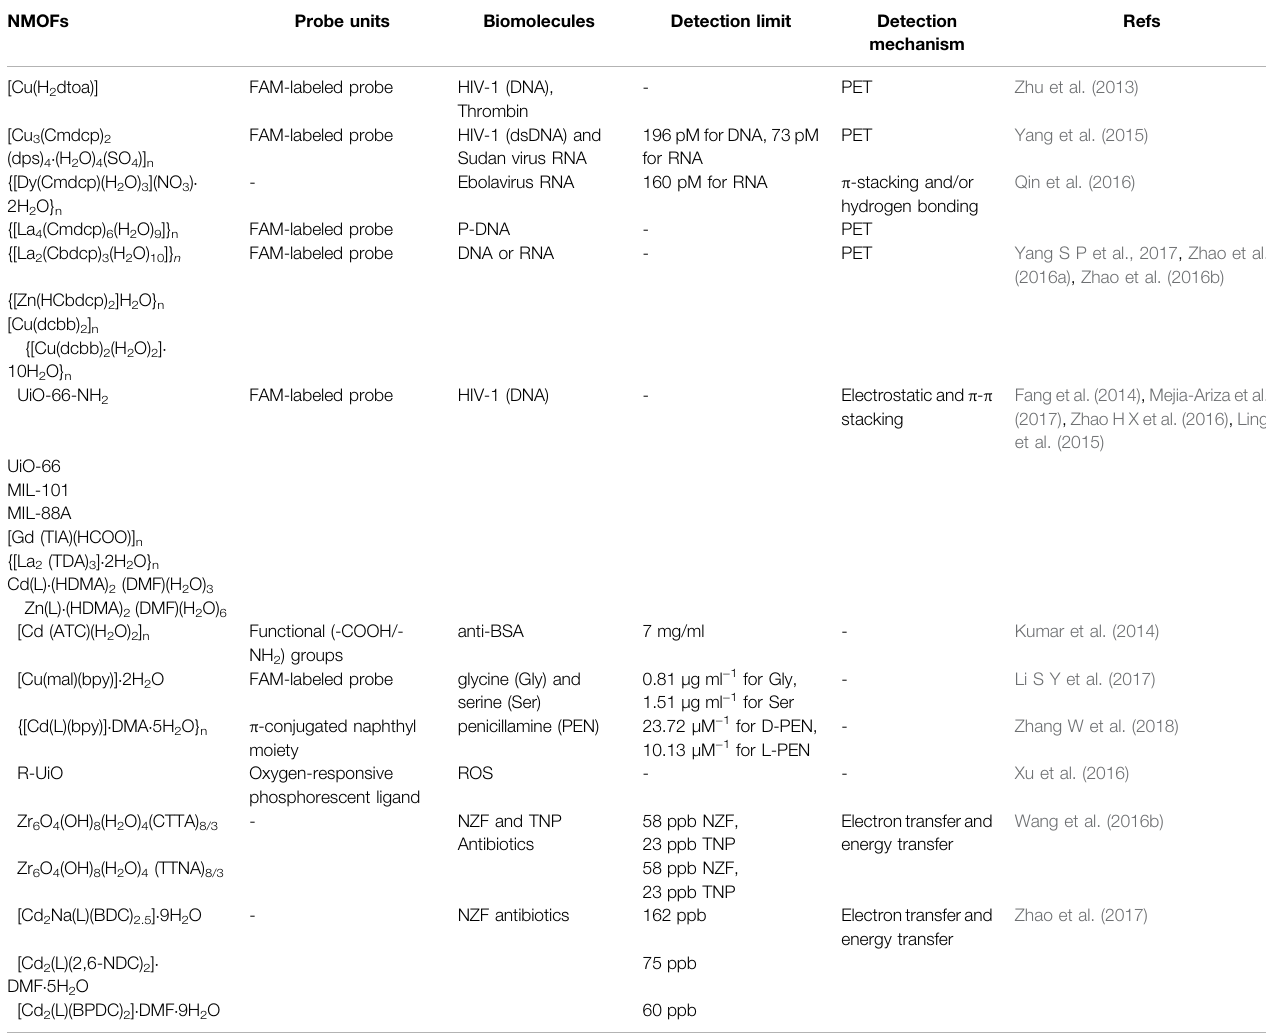
TABLE 3 | Various NMOFs as sensitive and selective sensors for screening biological macromolecules.